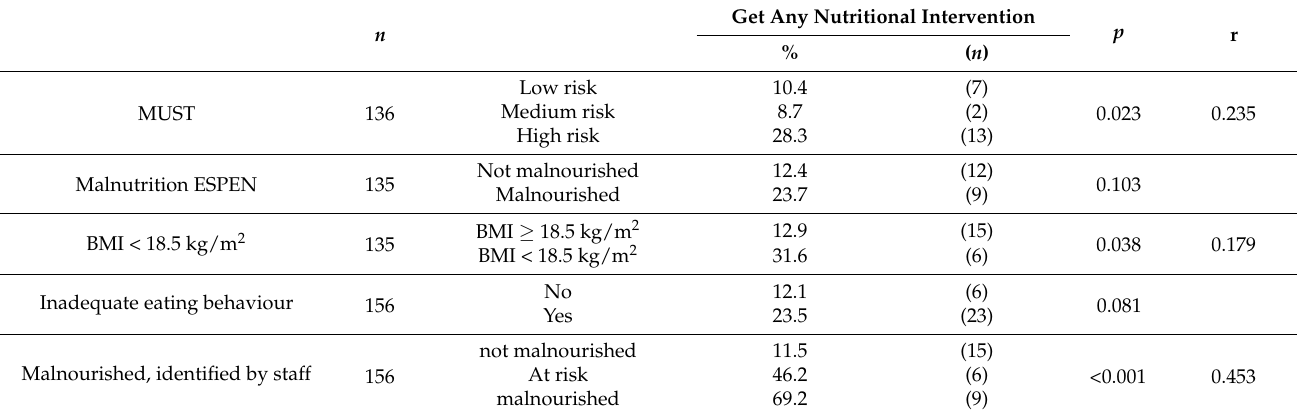
Table 4. Nutritional status and nutritional intervention (Chi 2